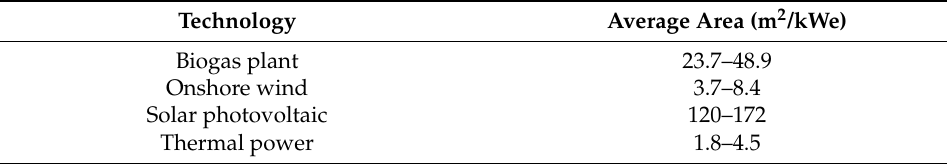
Table 4. Land use requirements for different energy